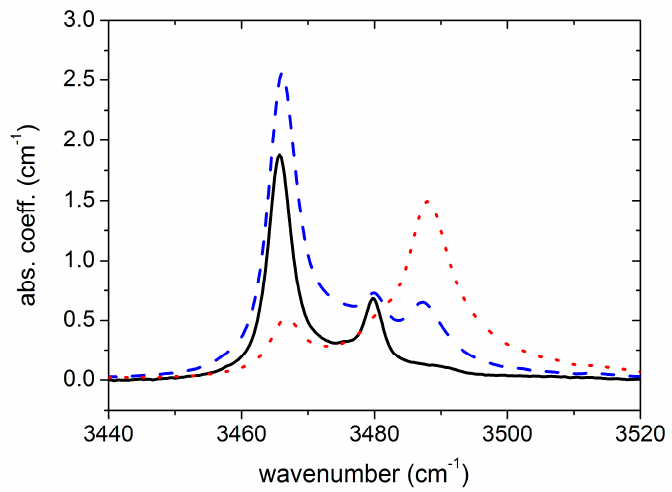
Figure 1. OH – absorption spectra of sLN crystals containing various amounts of Er (black continuous 0.24 atomic%, blue dashed 0.37 atomic%, and red dotted 0.54 atomic%). The full OH – content slightly varied from sample to sample.